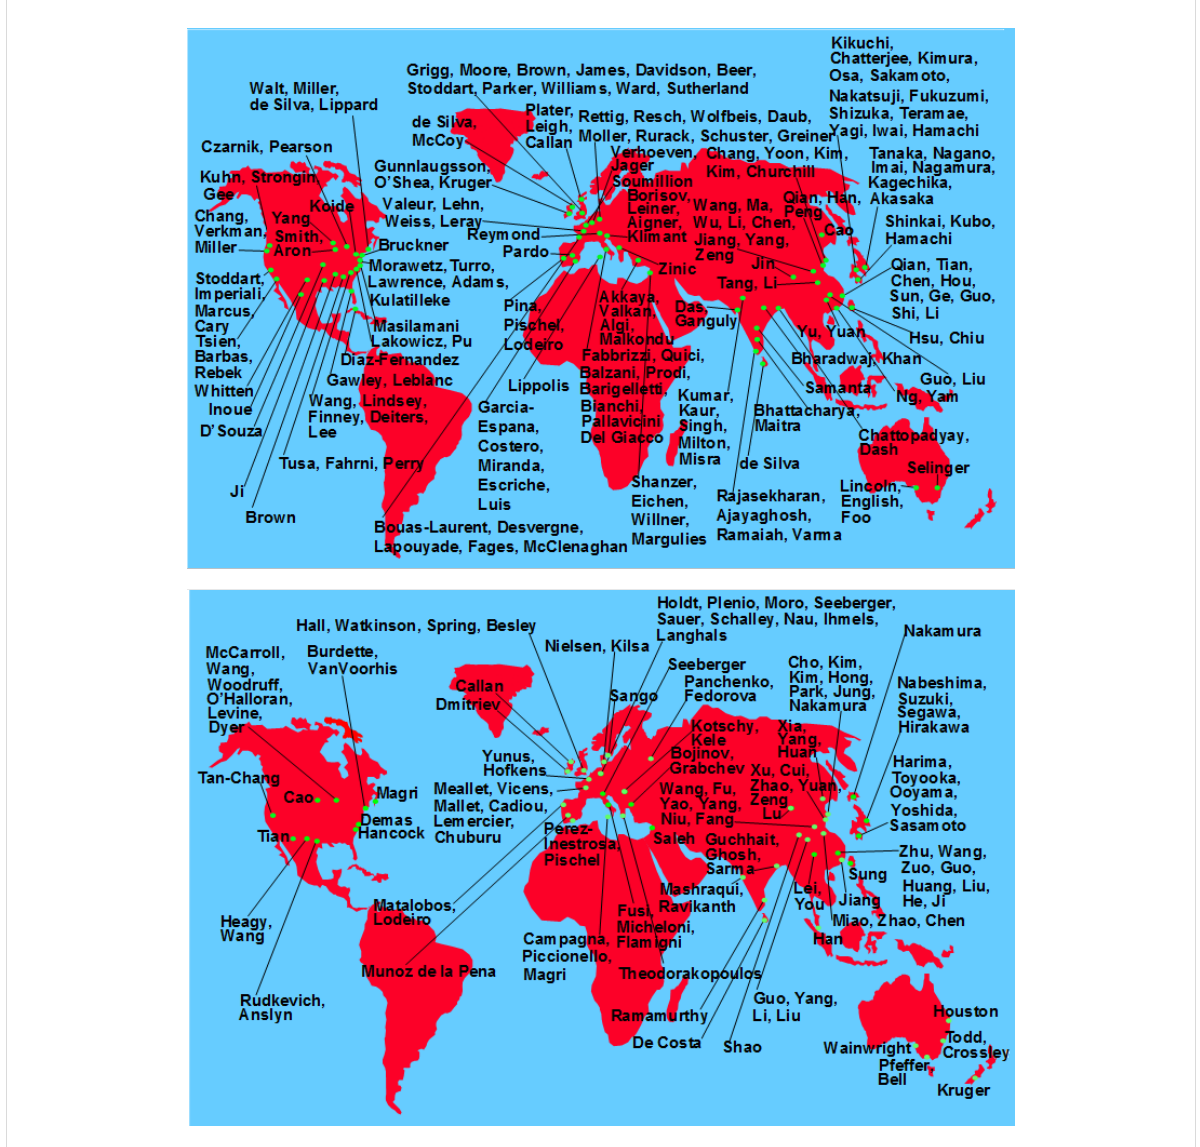
Figure 1: Approximate world maps of sources of fluorescent PET sensors/switches. Only the names of corresponding authors from the literature are given. Adapted from [15], Copyright (2015) The Royal Society of Chemistry.